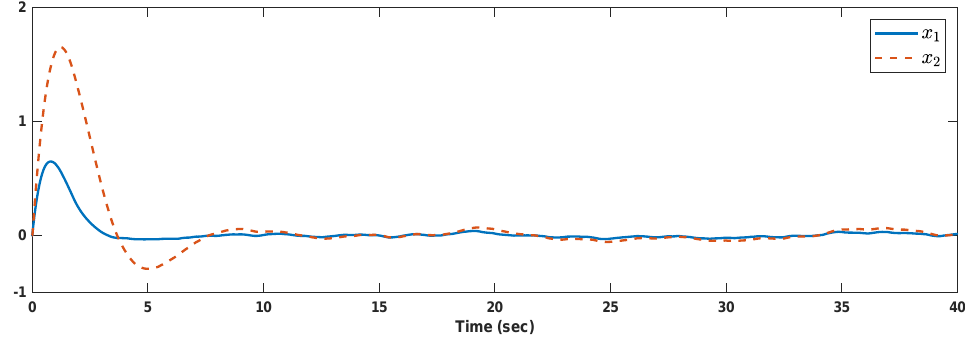
Figure 3. Example 2: Output